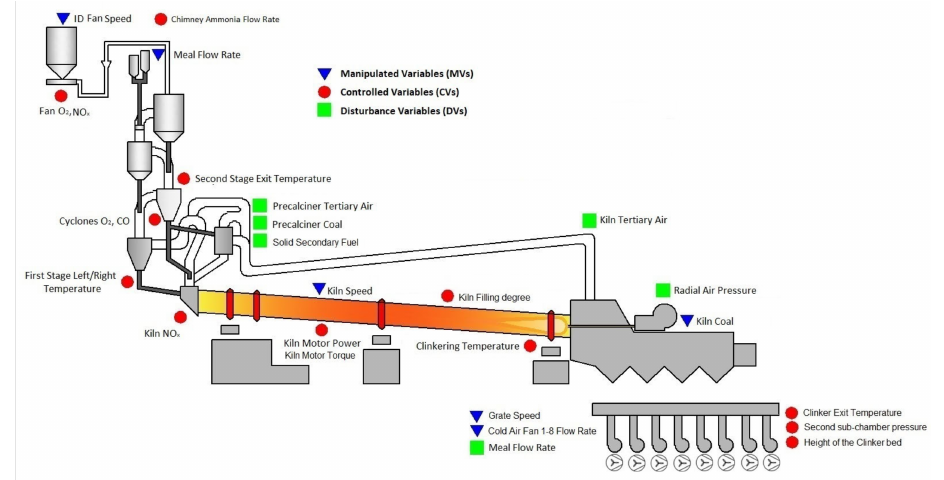
Figure 1. Clinker rotary kiln and grate